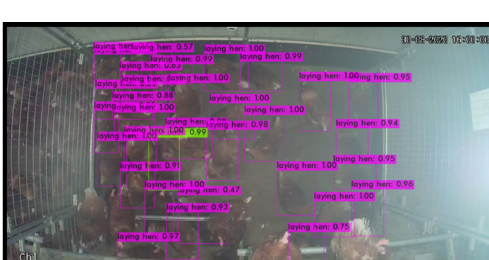
Figure 4. Object-detection classification performed on an image of the validation set using YOLOv4-